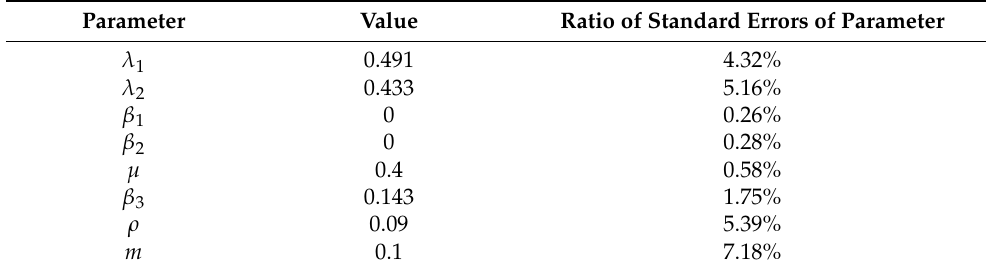
Table 4. Model estimated parameter values of stage